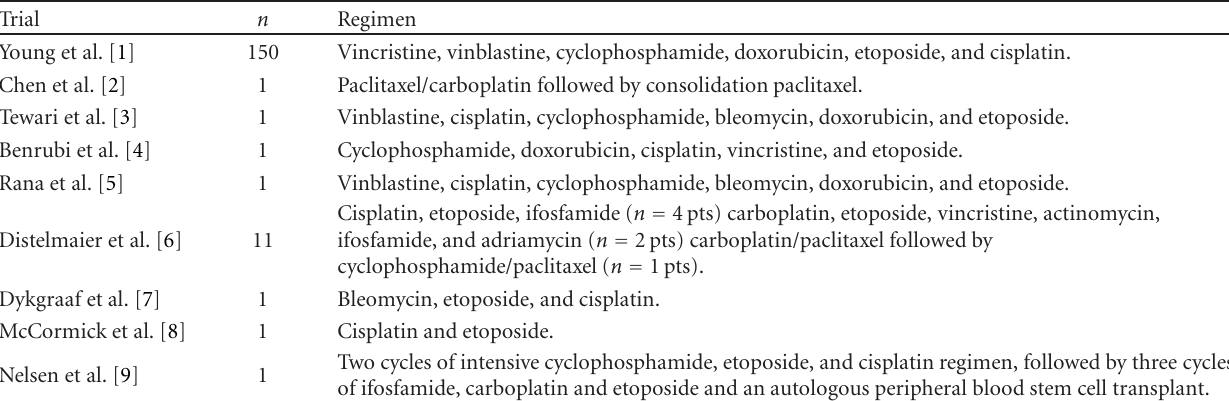
Table 1: Literature review of the treatment of small cell carcinoma of the